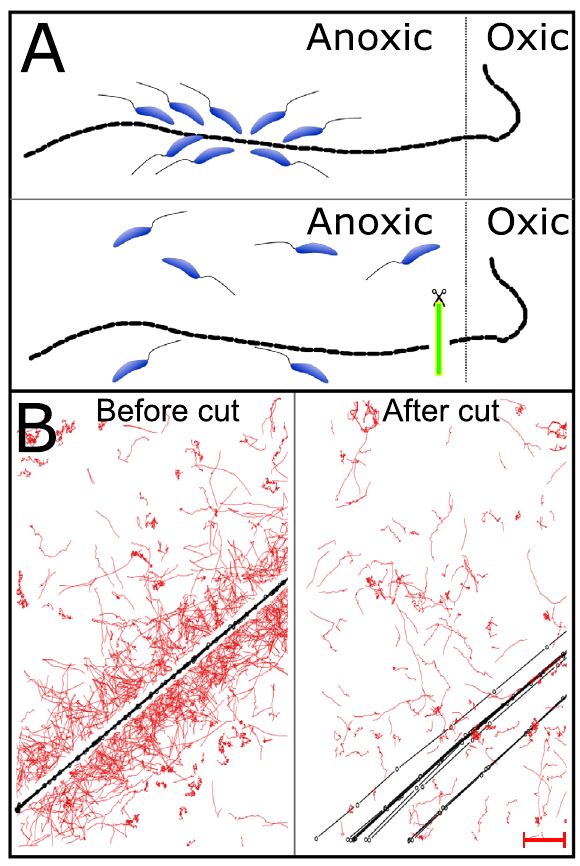
Fig. 2 | Principle and example of results of the laser cut experiment ( n =9). A Schematic representation. A cable bacterium connected to oxygen at the right side is cut nearthe oxic-anoxicinterface using alasermicrodissection microscope. B Result.Bacterialtracksonthesuboxicpartofacablebacteriumgeneratedfroma video before and after a cut. Red lines are tracks of swimming bacteria, and black lines and dots denote the position ofthe cable bacterium for every 50frames. The cable bacterium moves more after the cut as if the fi lament begins its oxygen chemotaxis (Scale bar, 10 µ m). Source data are provided as a Source Data fi